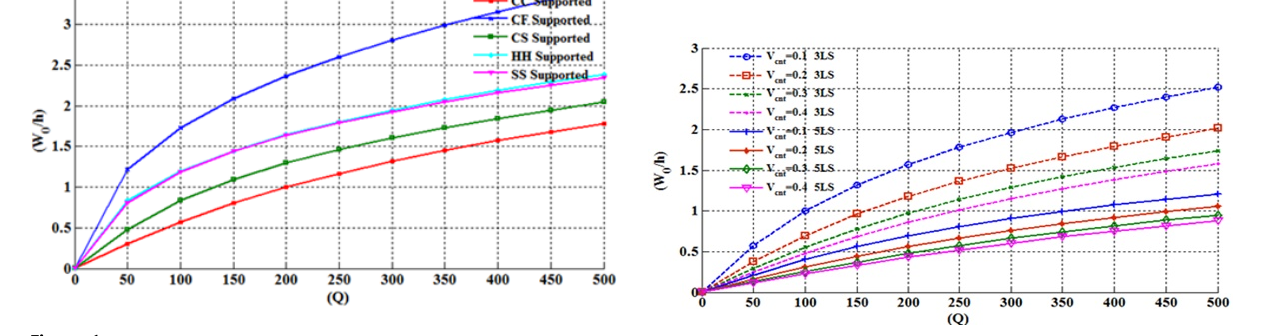
Figure 9 demonstrate the effect of variation in beam thickness ratio of the sandwich beam over TCD with load parameter. It is observed that as (a/h) increases, the transvers deflection of the beam also increases and this is due to decrease in the transverse resistant with respect to beam